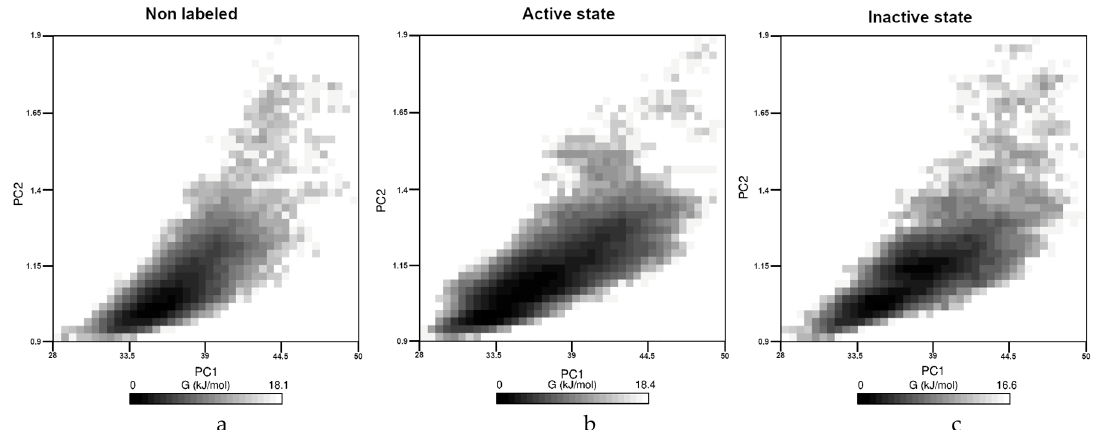
Figure 4. The Free Energy Landscape of the non-labeled ( a ), labeled ON ( b ) and labeled OFF ( c ) state. PC1 was always the SASA value (in nm 2 ) and PC2 was the RoG (in nm). Free energy was presented in kJ/mol.